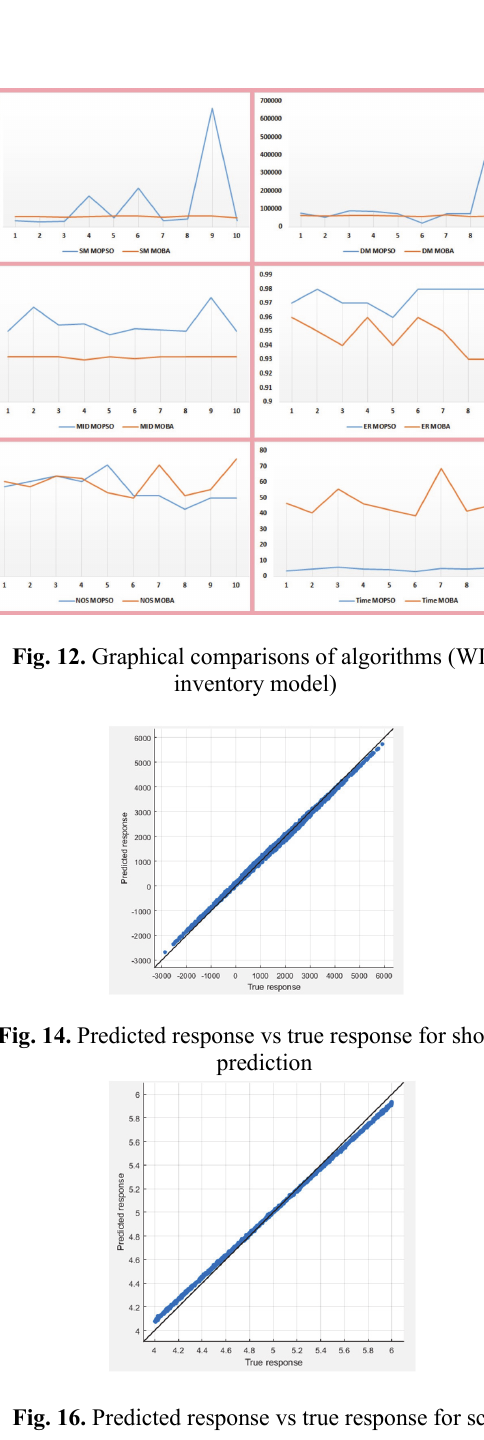
Fig. 15. Scrap prediction plot (yellow dot- record number and blue dot – response)